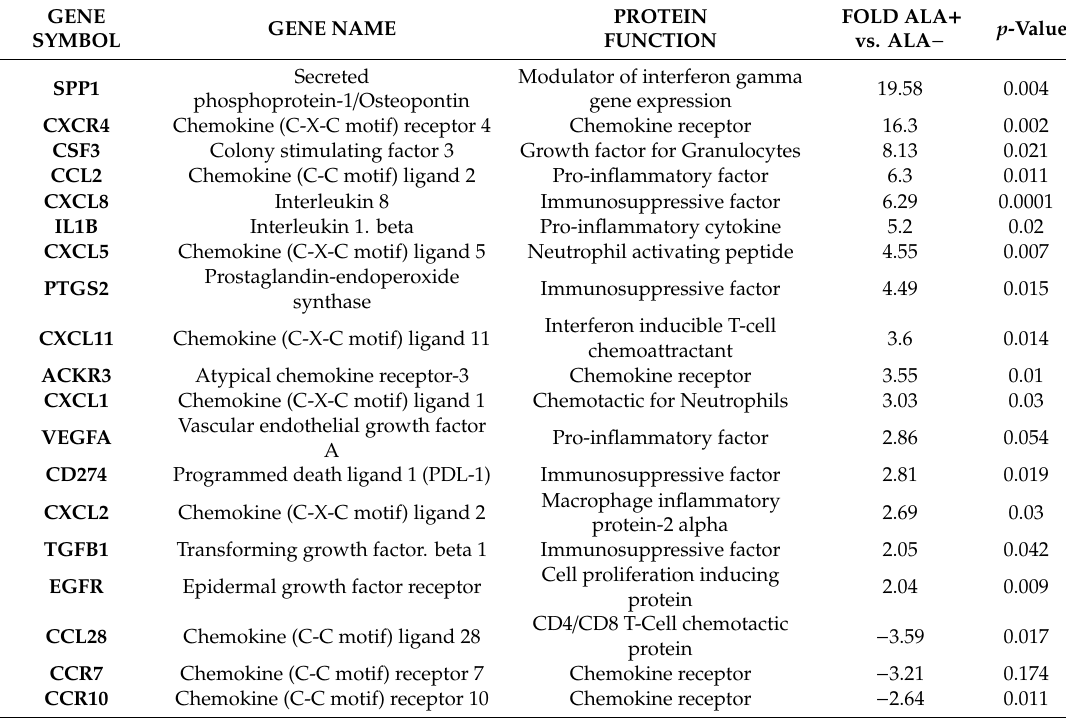
Table 2. Comparison of genes di ff erentially expressed in GASC-ALA + versus GASC-ALA − . Table show genes with a significant up or down-regulation, in GASC-ALA + compared with GASC-ALA − . Values indicate Fold Regulation calculated using the formula (2ˆ ( − Delta Delta CT)), i.e., the normalized gene expression (2ˆ ( − Delta CT)) in the test sample (GASC-ALA + ) divided by the normalized gene expression (2ˆ ( − Delta CT)) in the control ample (GASC-ALA − ). p values are calculated based on a Student’s t-test of the replicate 2ˆ ( − Delta CT) values for each gene in the control and treatment